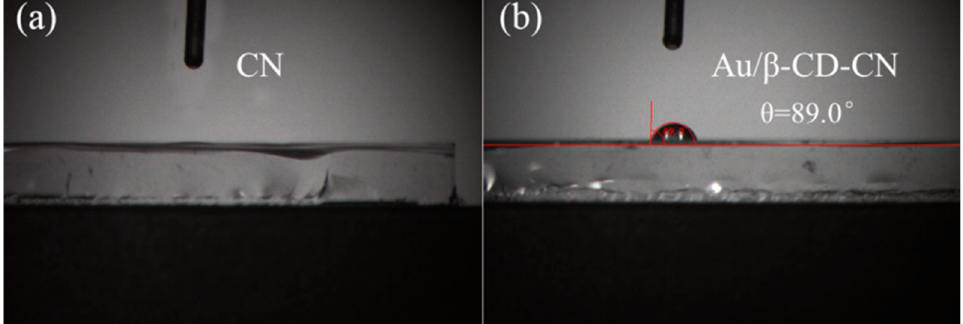
Figure 5. The water contact angle of CN ( a ) and Au/ β -CD-CN ( b ).